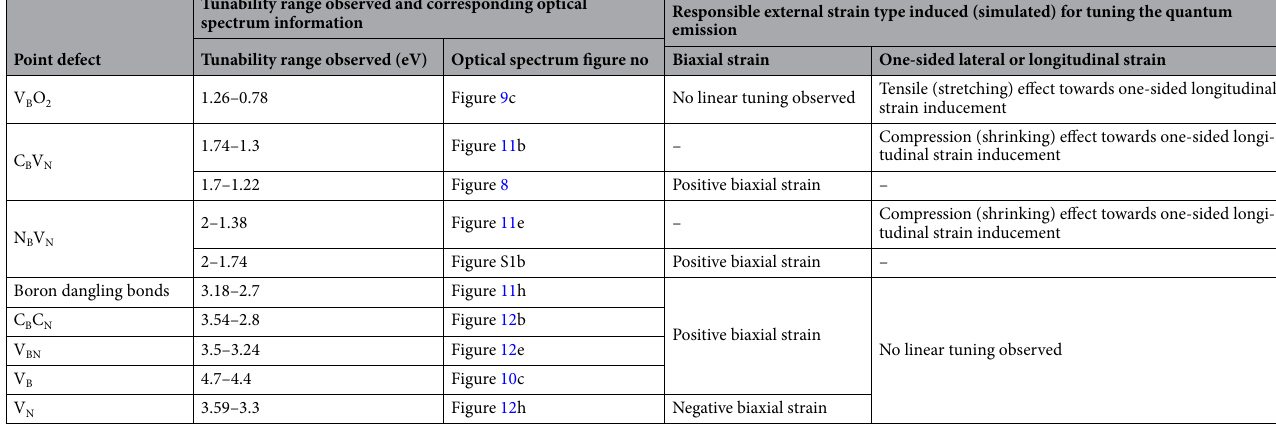
Table 3. Information related to quantum emission tunability range towards lower energy region and responsible external strain induced.